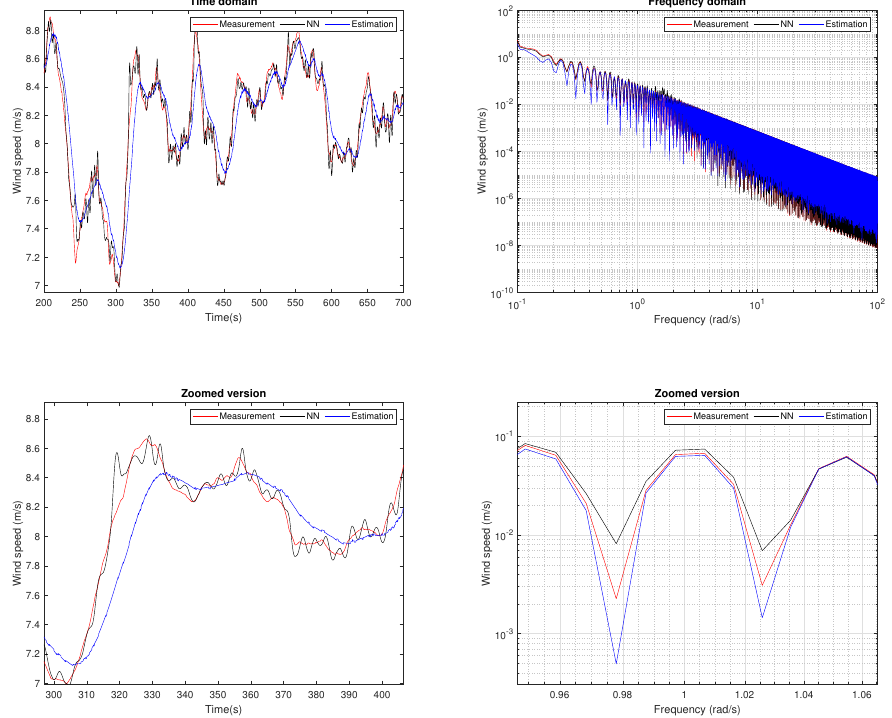
Figure 13. Scenario 4: Wind speed estimation from Turbine 5.